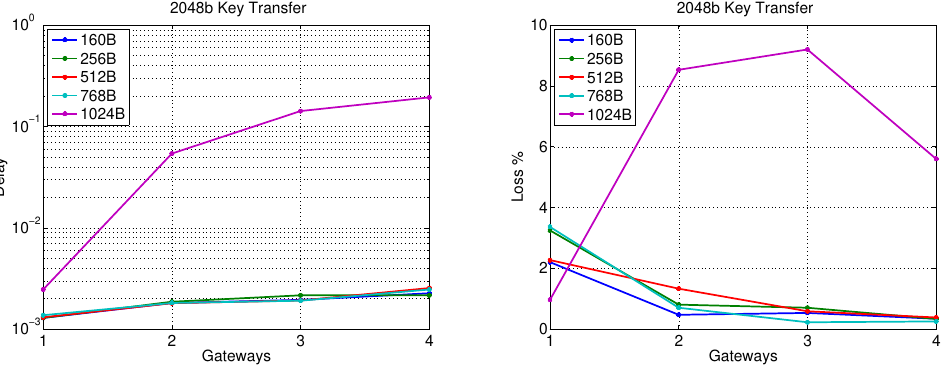
Figure 12. Gateway-PS communication performance for different number of gateways (2048-bit key